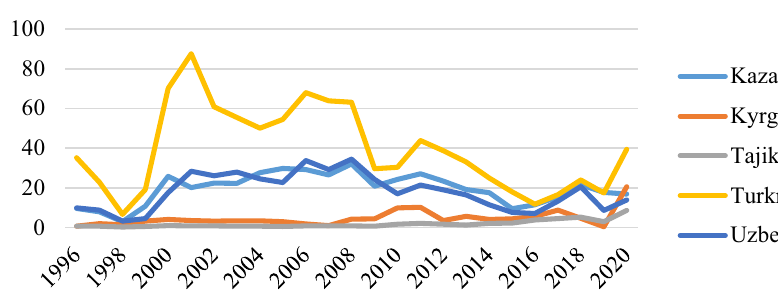
Fig. 1 Natural resource rents in Central Asia